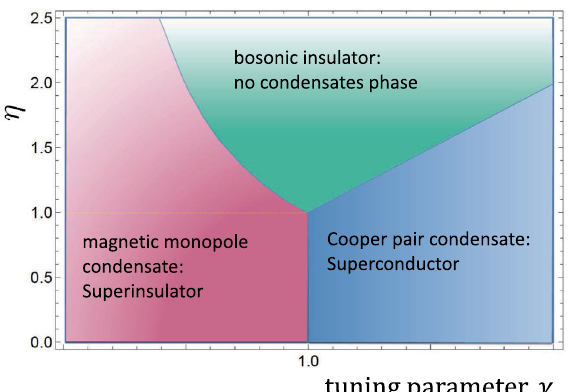
Fig. 2 Cooper pairs – quantum magnetic monopoles phase diagram at T = 0. The parameter η ¼ 2 π ð mv ‘ Þ G = fl uctuations and the material properties of the system. The inter-phases lines are η = 1/ γ ( γ < 1, η > 1), γ = 1 ( η < 1), and η = γ ( η > 1, γ >